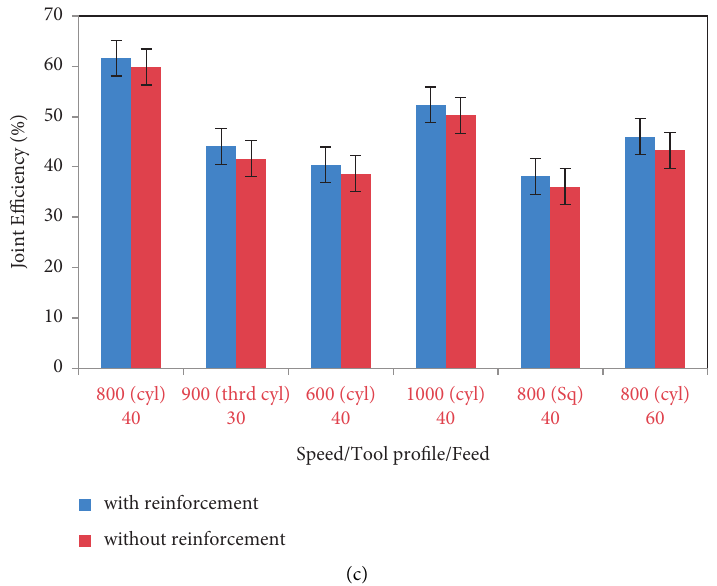
Figure 15: Process parameters effect on (a) UTS, (b) YTS, and (c) joint efficiency.